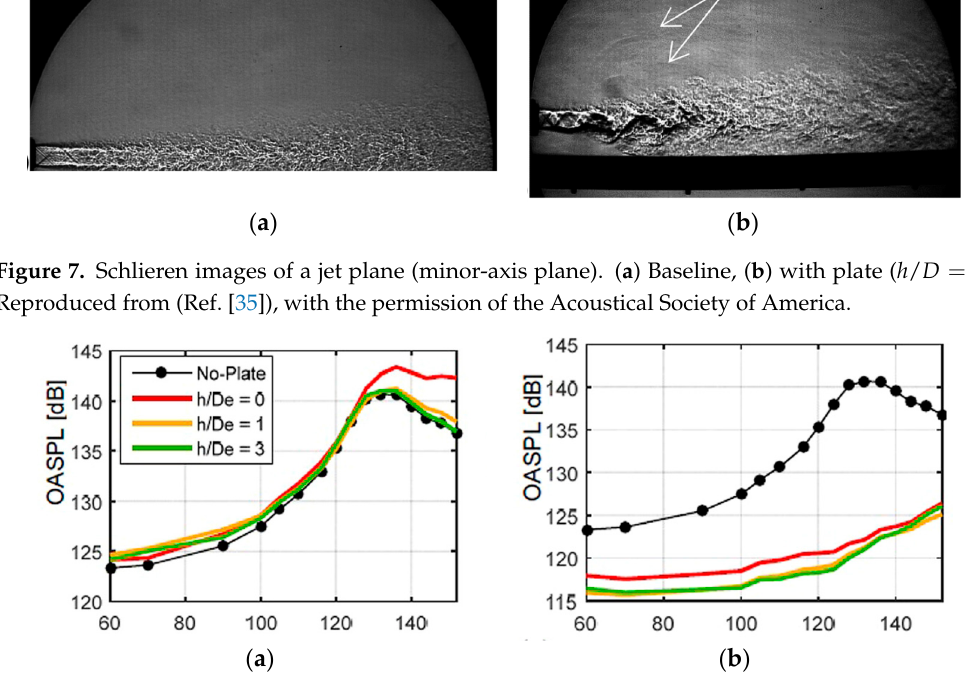
Figure 8. Far-field acoustic directivity of the ( a ) reflected side and ( b ) shielded side. Reproduced from (Ref. [35]), with the permission of the Acoustical Society of America.